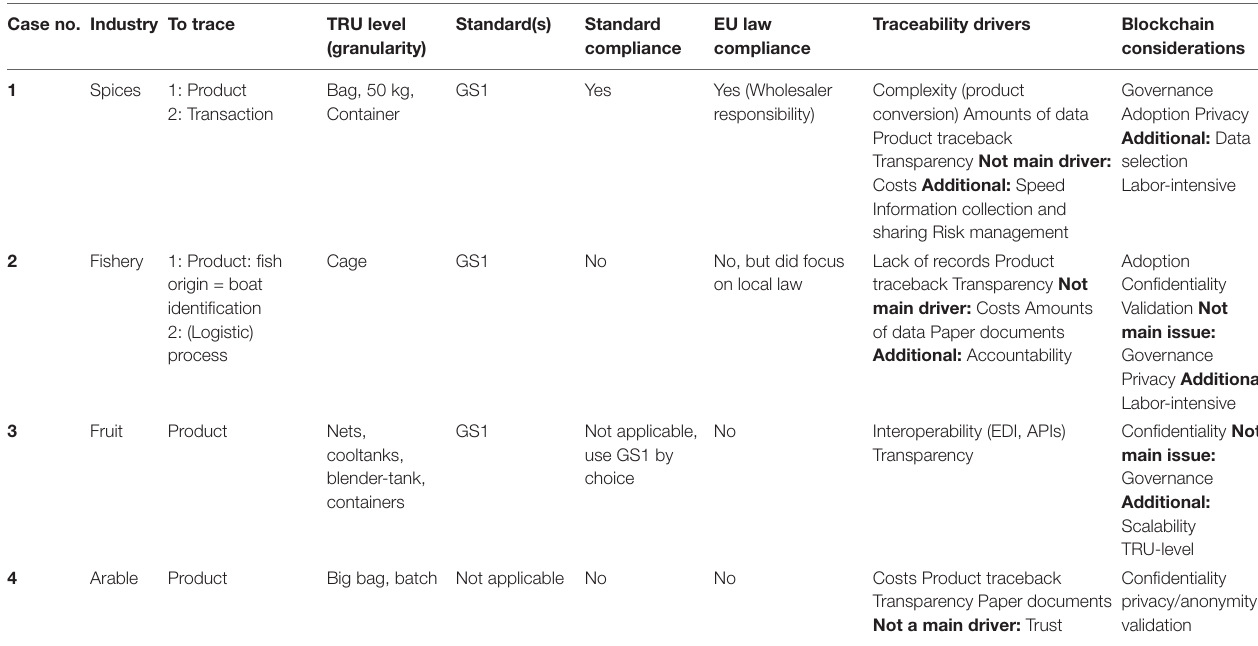
TABLE 4 | Use case